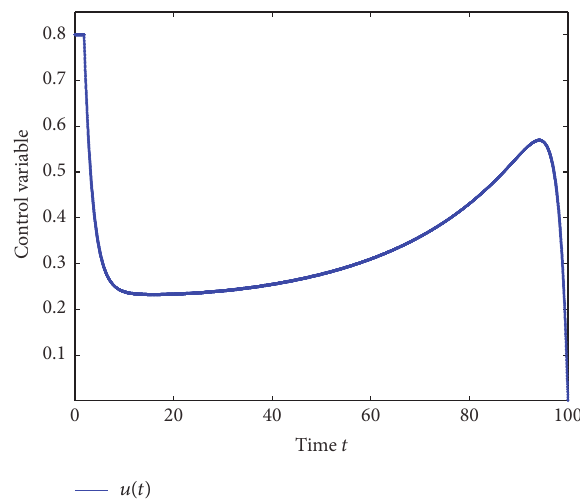
Figure 7: An optimal control function for system